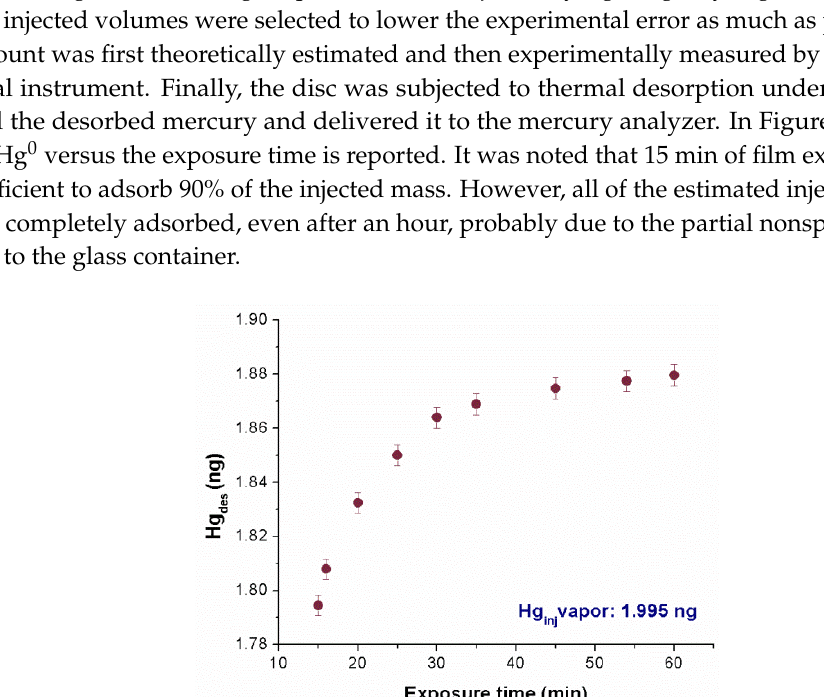
Figure 6. Atomic Force Microscope topography images of the quartz filter surface coated with a TiO 2 /AuNP layer, at different magnifications.